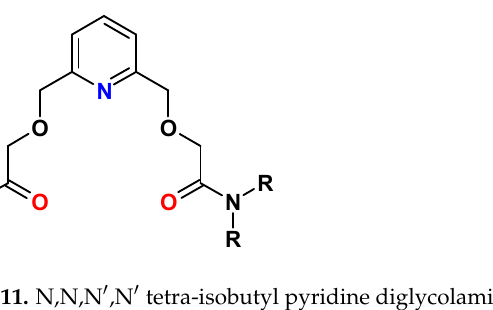
TAP (R = Oct) Three tri-aryl-pyridine ( TAP ) diamides (Figure 12) containing a pyridine spacer showed selective Pu(IV) extraction [171]. The extraction of Am(III), Eu(III), Sr(II) and Cs(I) was < 0.1%.